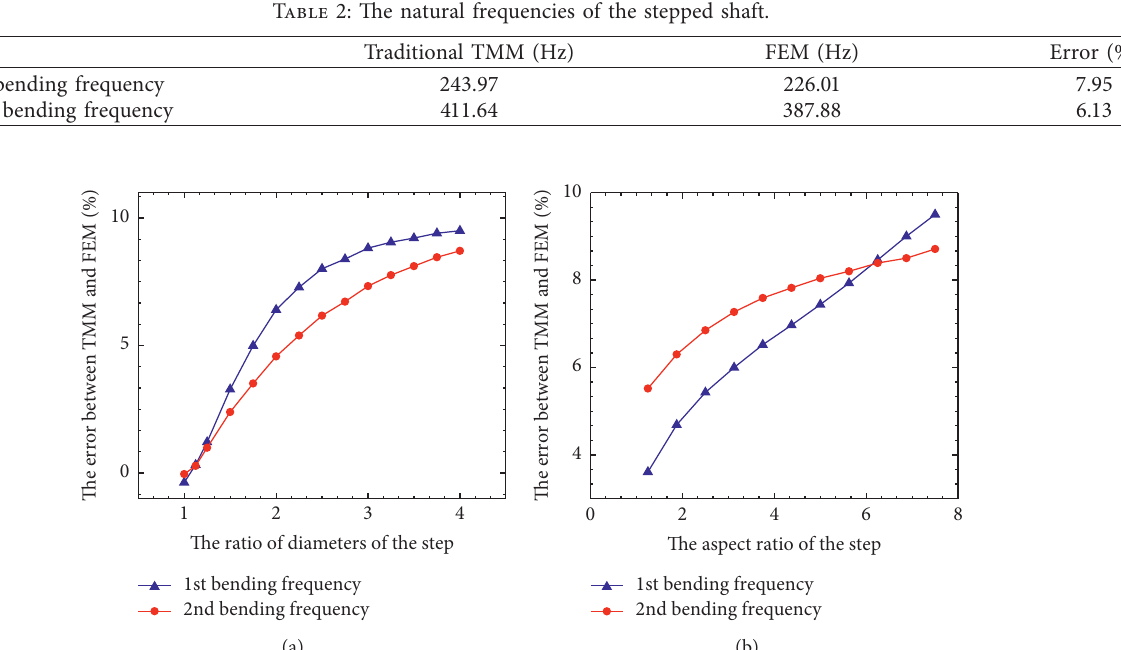
Figure 4: The variation of the error between TMM and FEM. (a) When the ratio of diameters of the step increases and (b) when the aspect ratio of the step